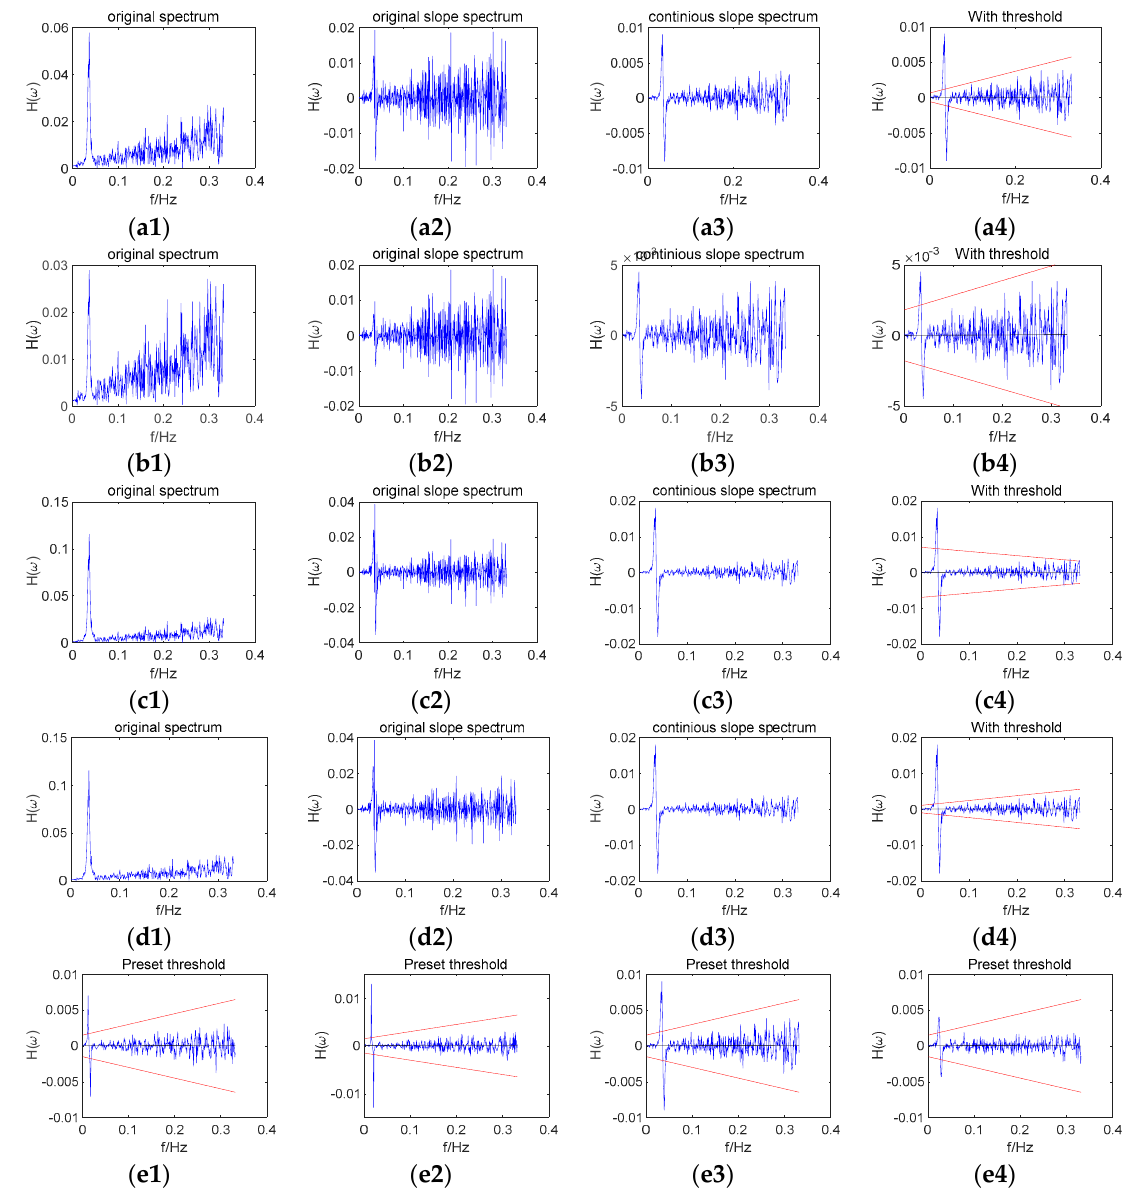
Figure 3. Parameter influence in the adaptive threshold setting combined strategy. ( a1 ) original spectrum, [50, 340], 0.06, adaptive, ( a2 ) original slope spectrum, [50, 340], 0.06, adaptive, ( a3 )